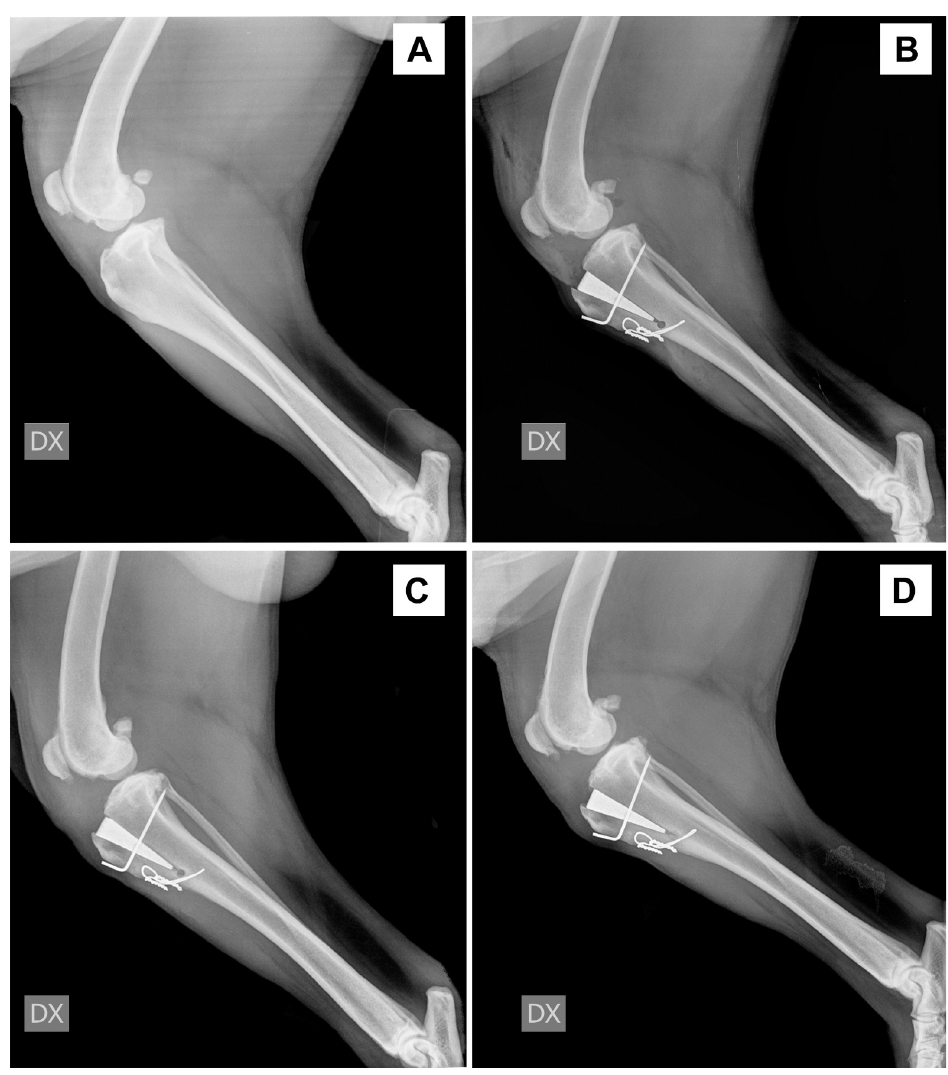
Fig 1. Radiographic evaluation over time intervals. Fig 1 A: preoperative radiograph (T0), B: immediate postoperative (T1), C: 30-days after surgery (T2), D: 90-days after surgery